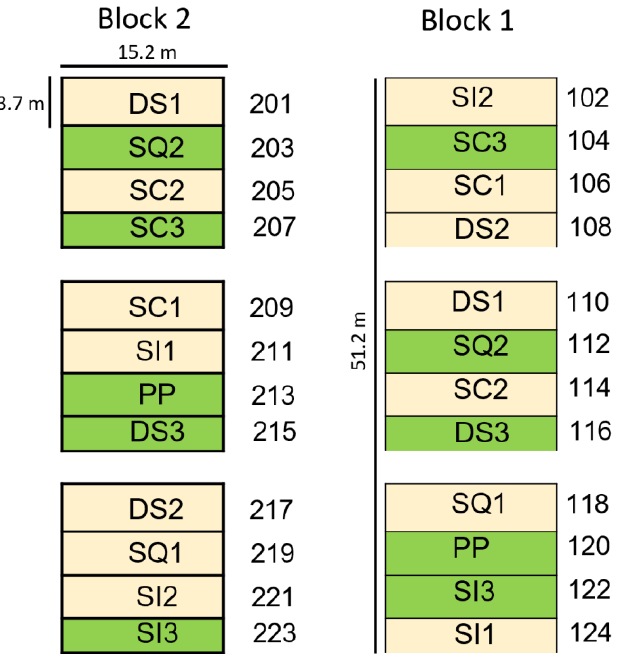
Figure 1. Diagrammatic representation of plot layout for two of the five replicate field blocks showing the cropping system (SQ — standard rotation, SC — soil conserving, SI — soil improving, DS — disease suppressive, and PP — nonrotation control) followed by the rotation phase (1, 2, or 3 — first, second, or third year of rotation). Potato is last crop in the rotation sequence and plots grown to potato in 2015 are shown in green. In subsequent years, different plots are grown to potato as determined by the cropping system phase. The number to the right of each plot indicates the plot number for identification purposes.